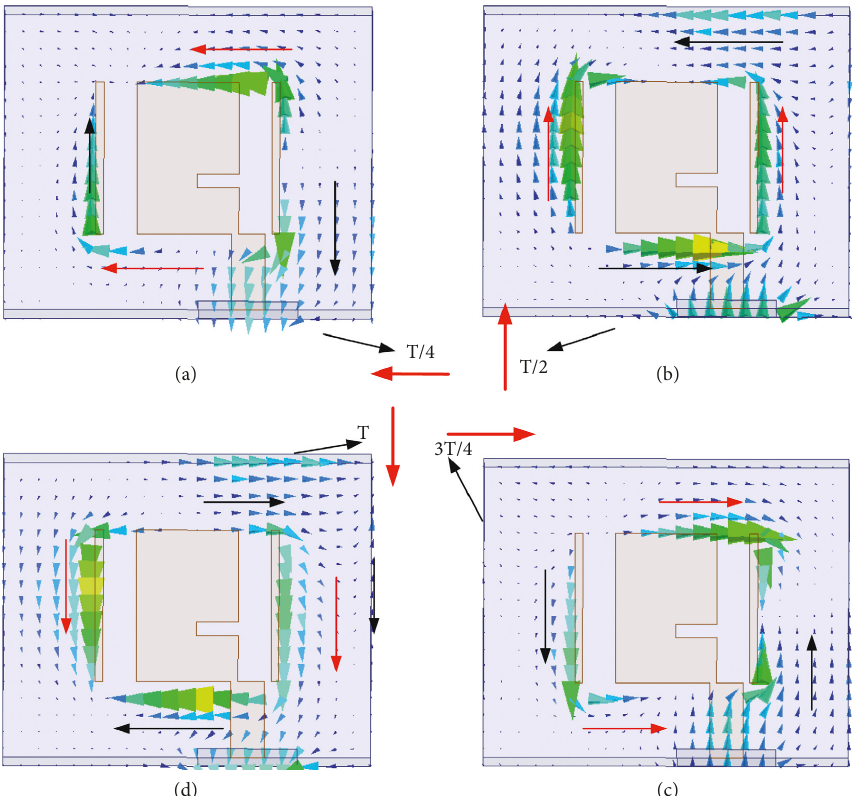
Figure 17: Simulated surface current distributions at 32.4 GHz.